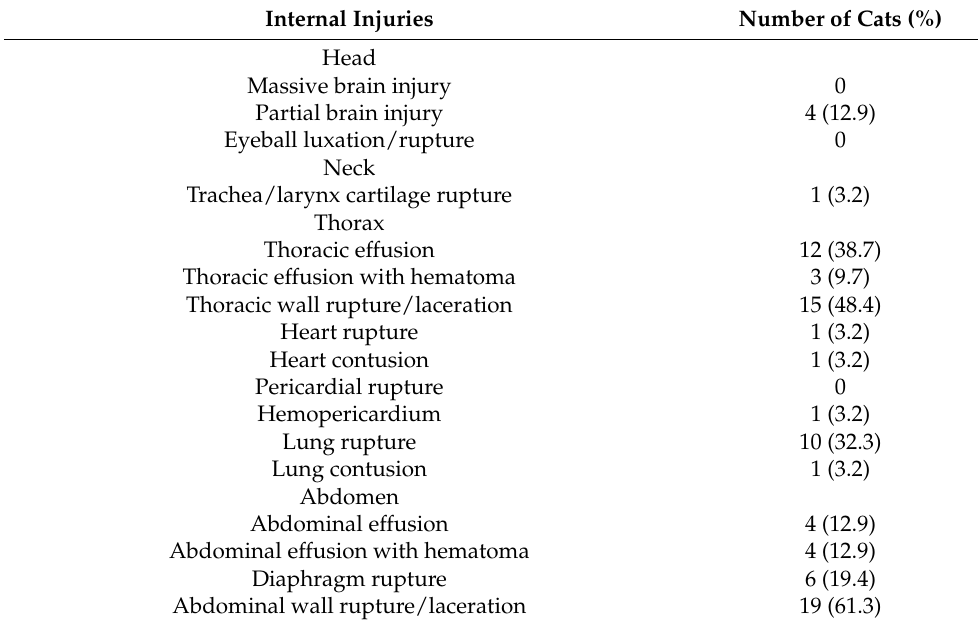
Table 1. Number and percentage of internal injuries in 31